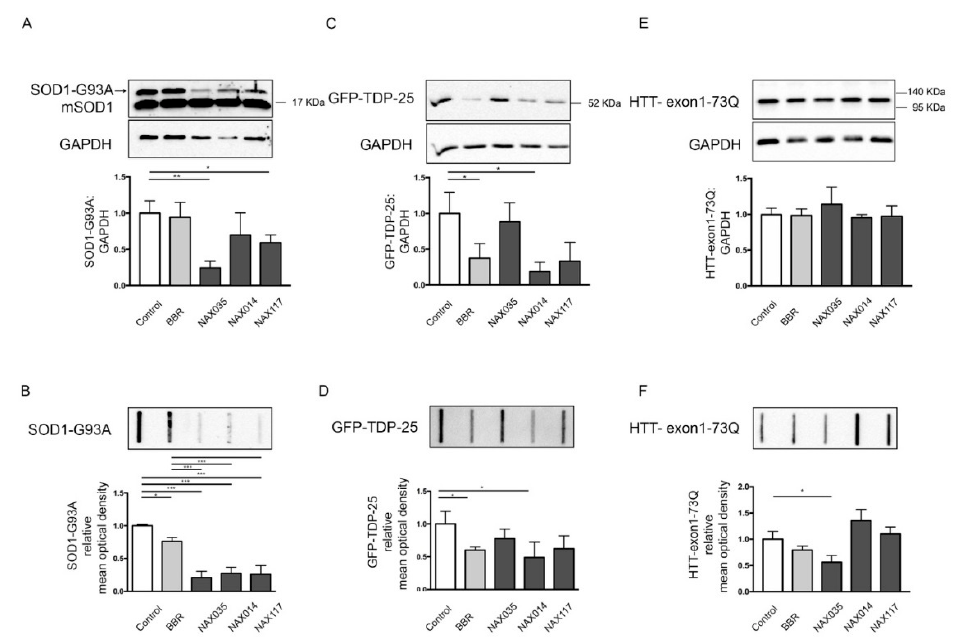
Figure 4. Effects of NAXs on misfolded proteins involved in ALS and HD. ( A , B ) NSC34 cells were transfected with plasmids coding for SOD1-G93A and treated BBR or NAX compounds for 48 h (BBR, NAX014 and NAX035 were used at 0.2 µ M, NAX117 was used at 0.5 µ M). ( A ) WB analysis was performed with anti-SOD1 antibody to detect exogenous human SO1-G93A and the endogenous murine SOD1 (mSOD1). GAPDH was used as loading control, the bar graph represents the mean optical density ± SD of SOD1-G93A: GAPDH (n = 3) (* p < 0.05, ** p < 0.01, one-way ANOVA, followed by Tukey’s test). ( B ) FRA was performed, the bar graph represents the mean optical density of SOD1-G93A ± SD (n = 3) (* p < 0.05, *** p < 0.001, one-way ANOVA, followed by Tukey’s test). ( C , D ) NSC34 cells were transfected with plasmids coding for GFP-TDP-25 and treated with BBR or NAX compounds for 48 h (BBR, NAX014 and NAX035 were used at 0.2 µ M, NAX117 was used at 0.5 µ M). ( C ) WB analysis was performed with anti-GFP antibody to detect the GFP-TDP-25. GAPDH was used as loading control, the bar graph represents the mean optical density ± SD of GFP-TDP-25: GAPDH (n = 3) (* p < 0.05, one-way ANOVA, followed by Tukey’s test). ( D ) FRA was performed, the bar graph represents the mean optical density of GFP-TDP-25 ± SD (n = 3) (* p < 0.05, followed by Tukey’s test). ( E , F ) NSC34 cells were transfected with plasmids coding for HTT-exon1-73Q and treated BBR or NAX compounds for 48 h (BBR, NAX014 and NAX035 were used at 0.2 µ M, NAX117 was used at 0.5 µ M). ( E ) WB analysis was performed with anti-HTT antibody to detect exogenous HTT-exon1-73Q. GAPDH was used as loading control, the bar graph represents the mean optical density ± SD of HTT-exon1-73Q: GAPDH (n = 3) (one-way ANOVA, followed by Tukey’s test). ( B ) FRA was performed, the bar graph represents the mean optical density of HTT-exon1-73Q ± SD (n = 3) (* p < 0.05, one-way ANOVA, followed by Tukey’s test).